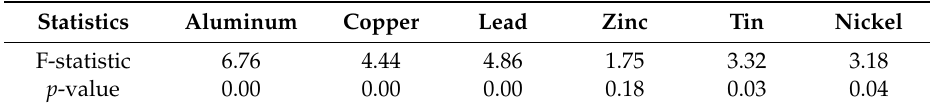
Table 5. Joint hypothesis testing: monthly data analysis